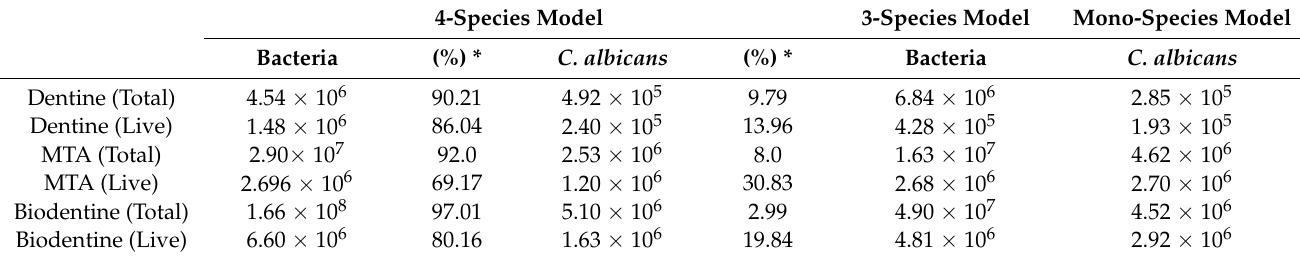
Table 1. Percentage composition of mixed-species biofilm model and total and live CFE counts for C. albicans and bacteria in all biofilms following biofilm growth on unaltered MTA, Biodentine and dentine